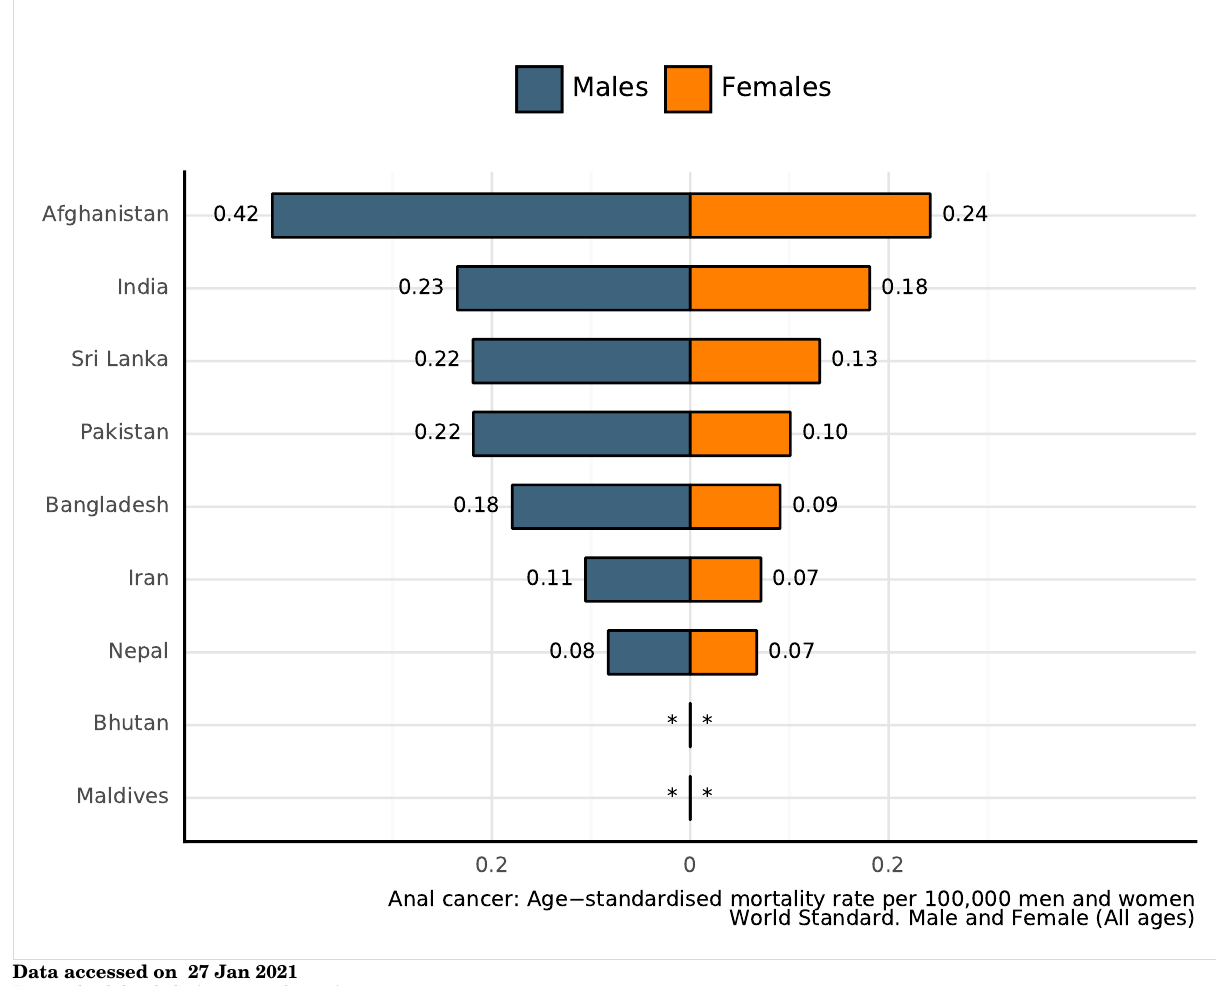
0.2 0 0.2 Anal cancer: Age standardised mortality rate per 100,000 men and women World Standard. Male and Female